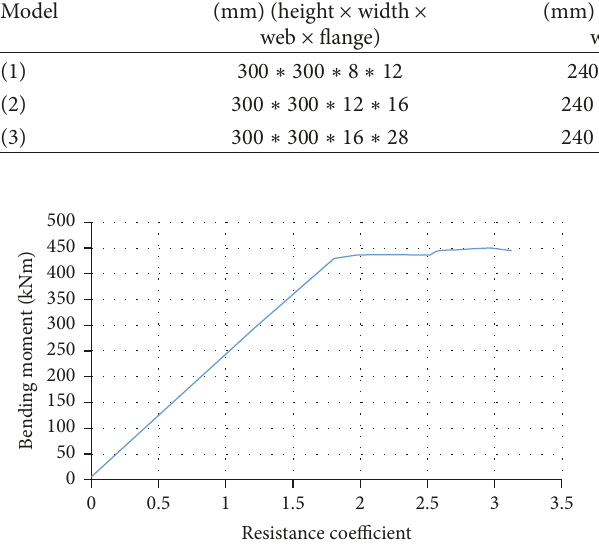
Figure 13: Bending moment-resistance coefficient curve of the steel beam connected with the removed middle column.